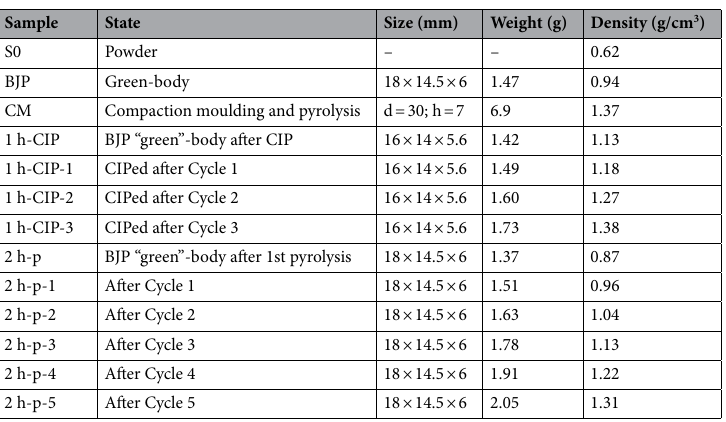
Table 2. Graphite samples prepared according to each step of the process